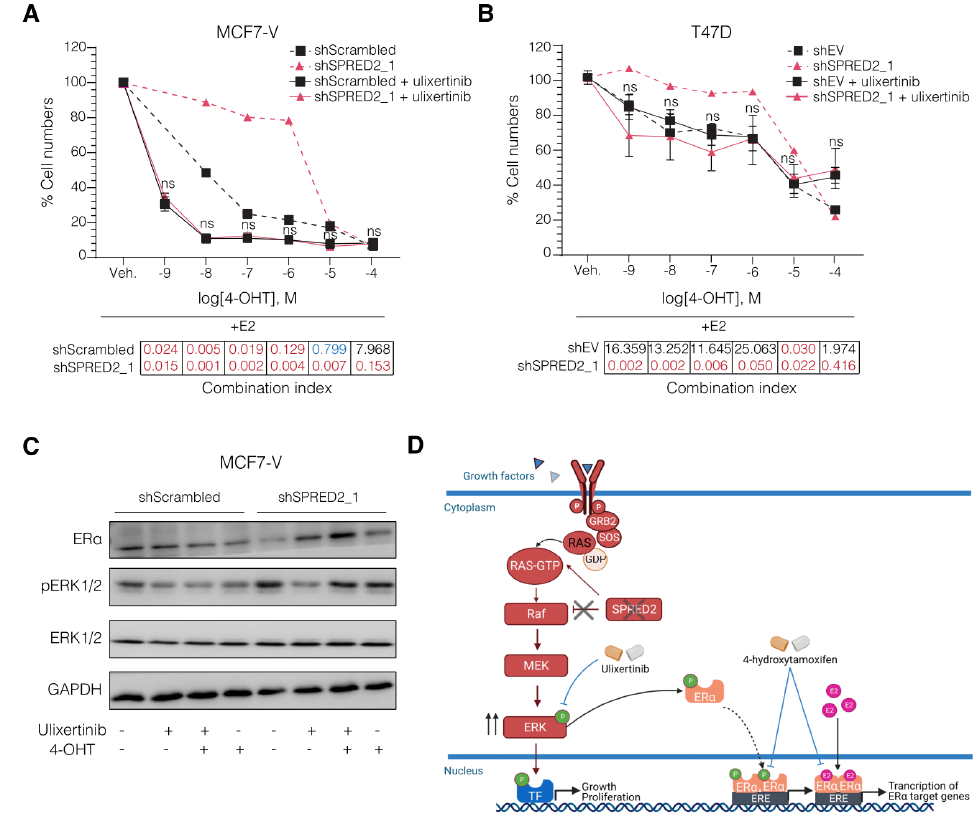
Figure 4. Ulixertinib resensitizes SPRED2-deficient BC cells to 4-OHT. ( A,B ) Dose–response curves with increasing doses of 4-OHT in combination with ulixertinib at 100 nM for MCF7-V ( A ) and 300 nM for T47D ( B ). The dashed curves indicate the response to 4-OHT without ulixertinib, copied from Figure 2G,I for comparison. Statistical significance was determined with a two-way ANOVA with Bonferroni multiple comparison test for both panels. All error bars represent the standard er- rors of the means (mean ± SEM). Significance is indicated compared to the shScrambled (MCF7-V) or shEV (T47D) samples, each treated with ulixertinib (ns for p > 0.05). Tables below the curves indicate the combination index of 4-OHT with ulixertinib for each dose, categorized as very strong synergism (red), moderate synergism (blue), and strong antagonism (black), calculated by the Chou- Talalay method with the software CompuSyn. ( C ) Representative immunoblots showing the changes in ERα and p-ERK protein levels of MCF7-V cells after treatment with 4-OHT and ulixer- tinib alone or in combination. ( D ) Schematic representation of the proposed mechanism driving 4- OHT resistance in SPRED2 deficiency and how to overcome it. The illustration was created with BioRender.com. Uncropped images of immunoblots with molecular weight standards are available in Figure S5. 4. Discussion BC is the leading cause of cancer-related deaths worldwide. Endocrine therapy re- mains the foundation for the treatment of patients with ERα+ breast cancer [60,61]. Unfor- tunately, resistance to endocrine treatment occurs in a large proportion of patients with BC. About 40% of the women treated with tamoxifen for up to 5 years will present with